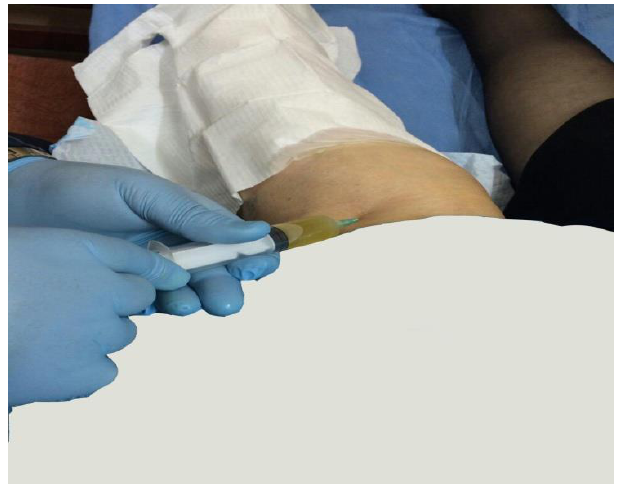
Figure 2. Aspiration of synovial